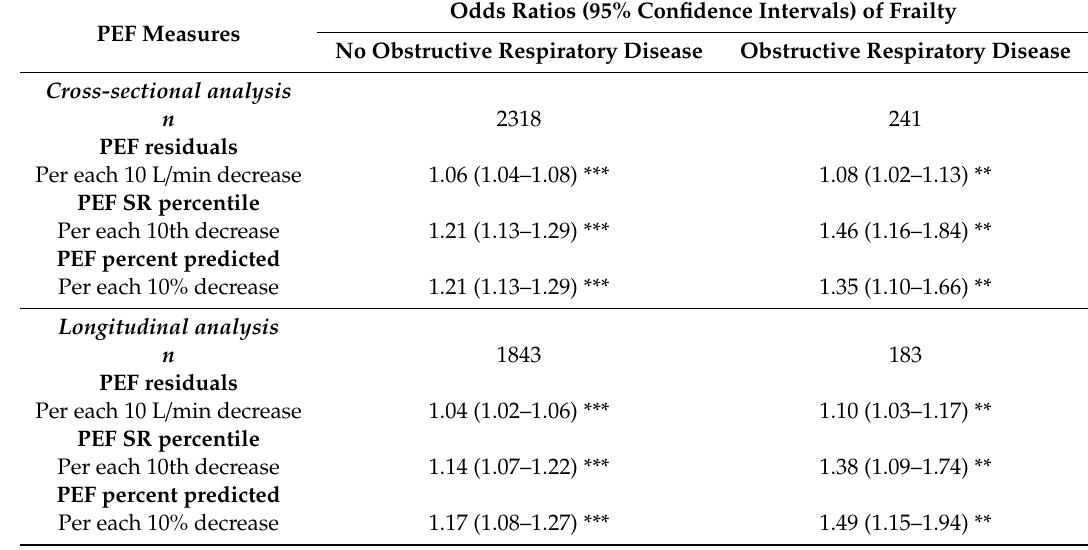
Table 4. Association between peak expiratory flow and frailty in participants stratified by the presence of obstructive respiratory diseases (chronic obstructive pulmonary disease and / or asthma).